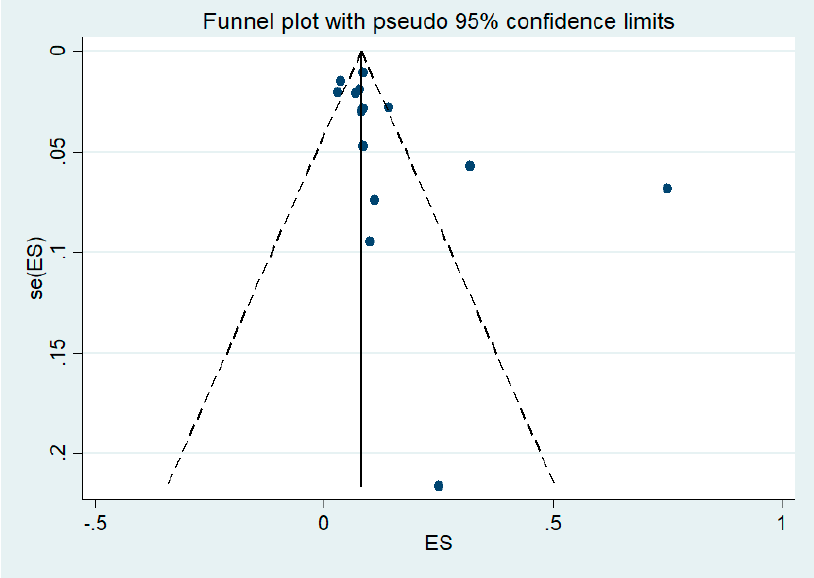
Figure 8. Funnel plot. ES: effect size (odds ratio), se: standard error.